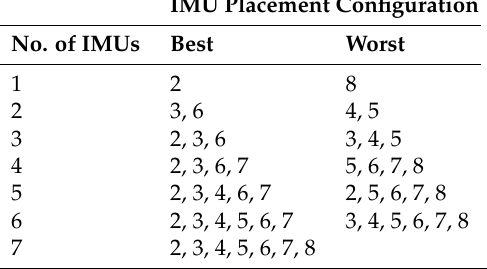
Table 6. Best and worst placement configurations of IMUs, given the number of IMUs used. IMU locational labels are as follows (see Figure 2): 2—back, 3—right thigh, 4—right shank, 5—right foot, 6—left thigh, 7—left shank, 8—left